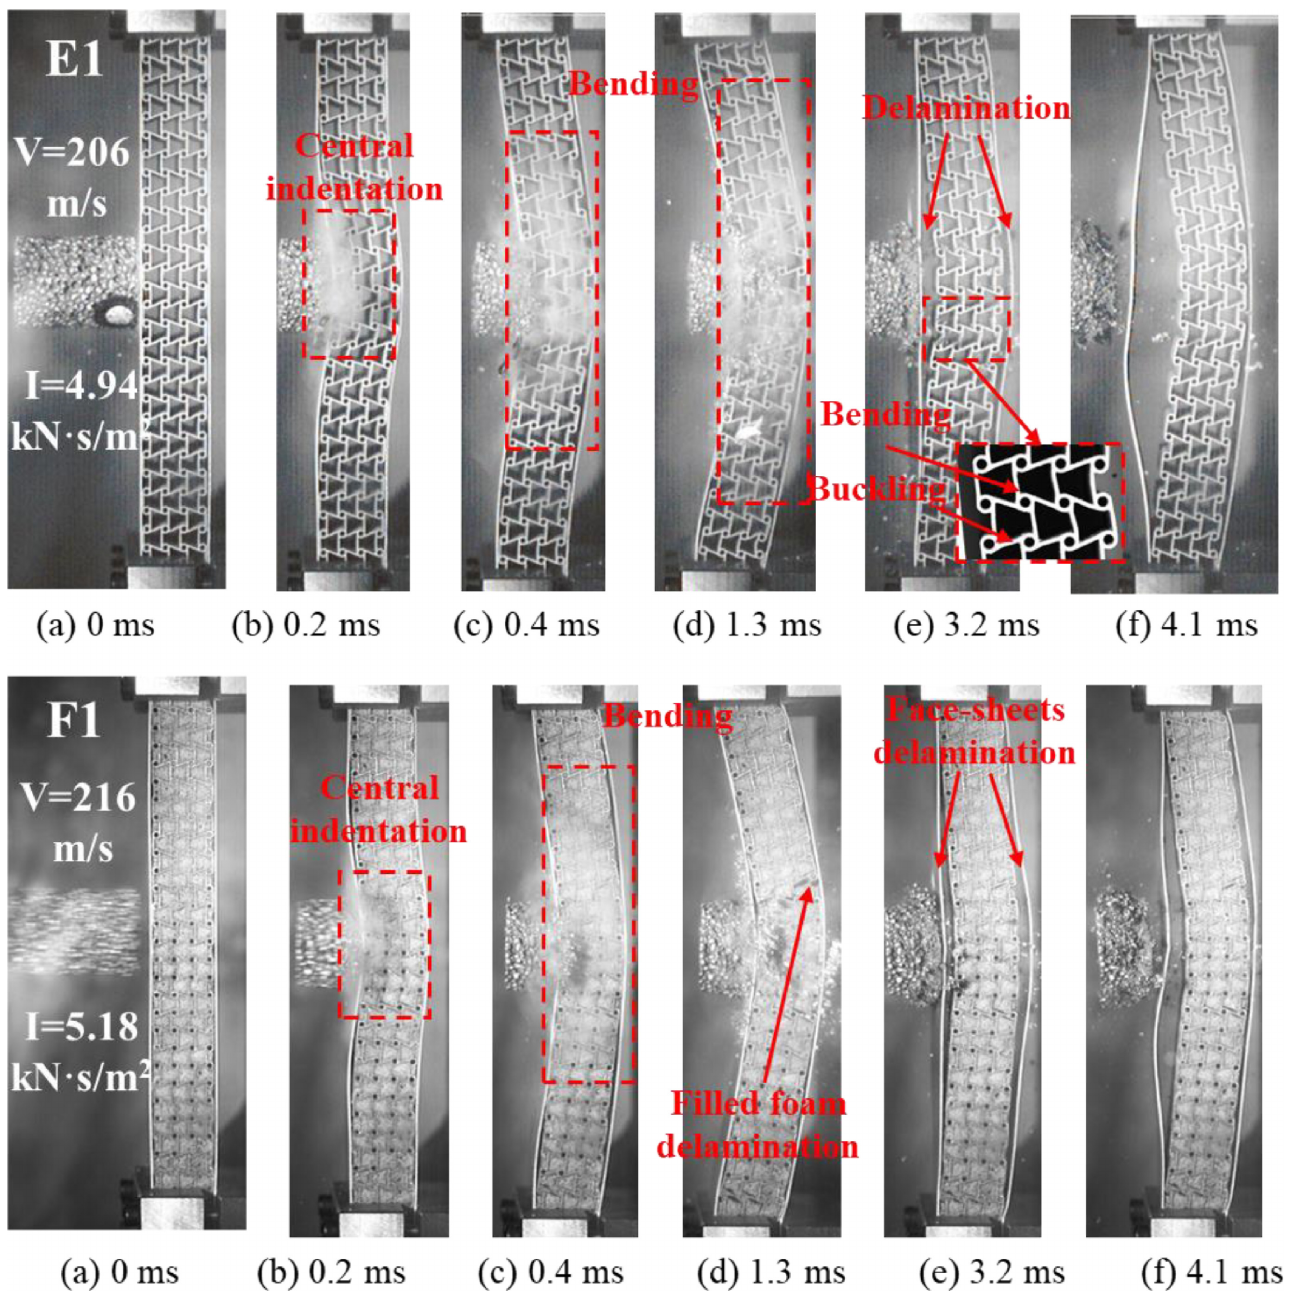
Figure 26. Dynamic response recorded by high-speed camera of auxetic sandwich panels under impact: (E1) Panel without PU foam filling; (F1) Panel filled with PU foam. Reprinted with permission from Ref. [223]. Copyright 2023,